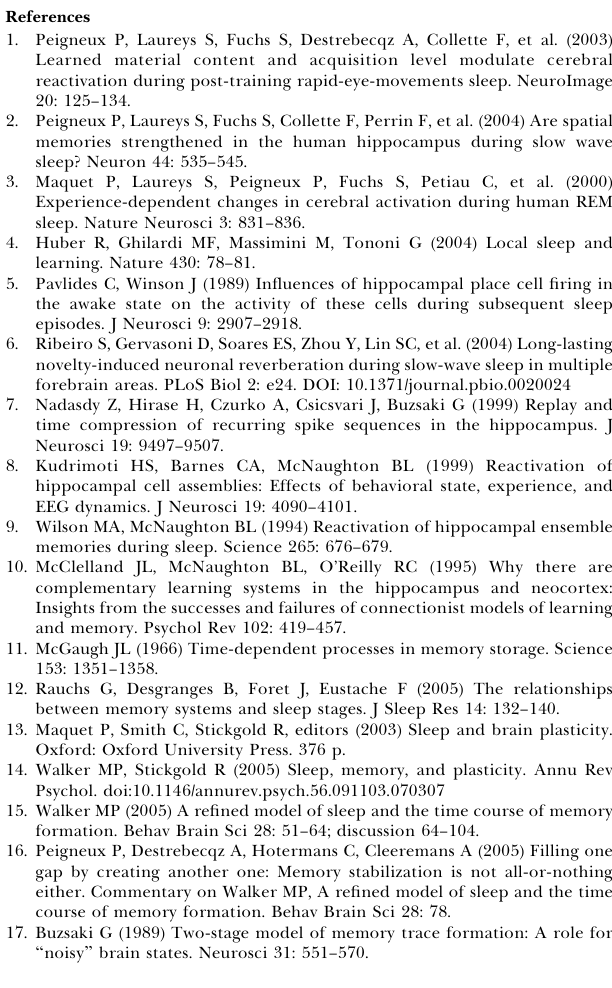
Table S1. Post-Spatial Training Activity (Main Effects) Table S2. Post-Procedural Training Activity (Main